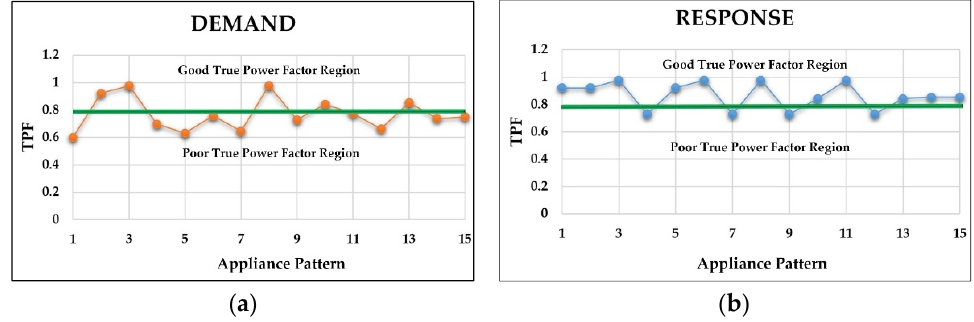
Figure 9. The TPFs of appliance usage patterns according to: ( a ) demand; ( b ) responses to the insights.